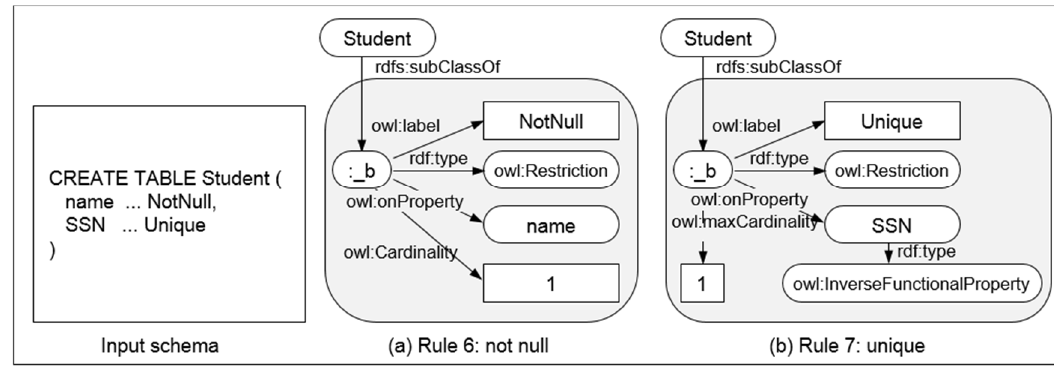
Figure 15. Examples of mapping integrity constraints (Rule 6,7).